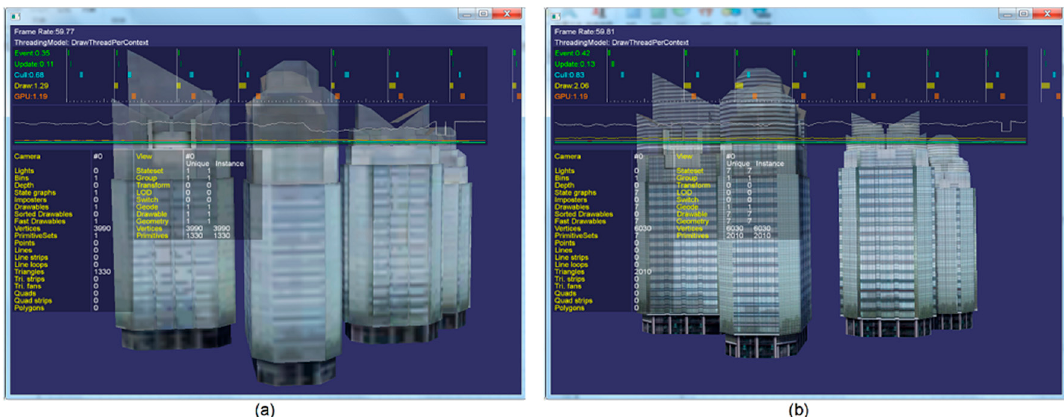
Figure 14. Visualization of model conflation: ( a ) conflation model; ( b ) original model.